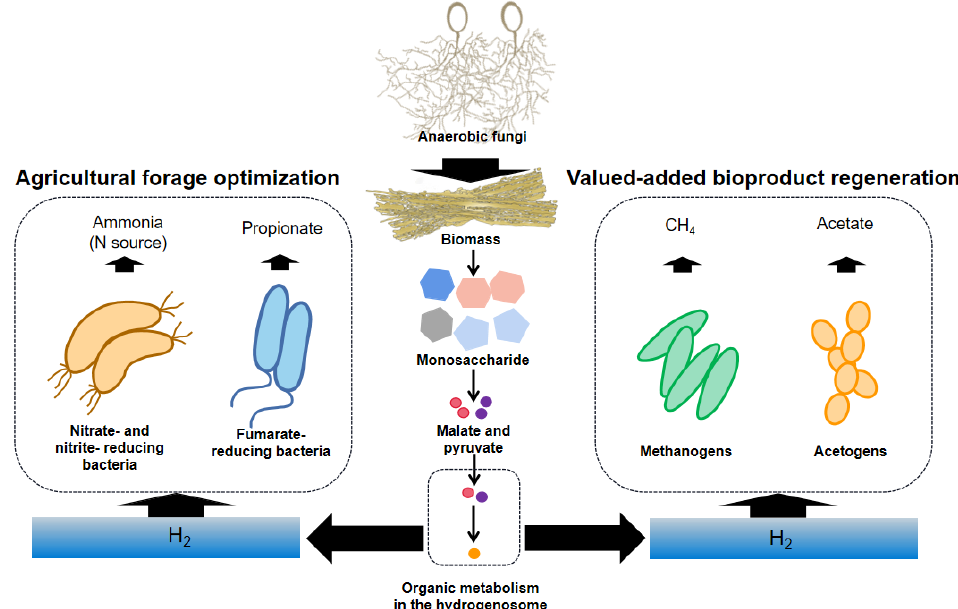
Figure 6. The role of the hydrogenosome and its metabolites. The metabolites (mainly H 2 ) can be used by nitrate- and nitrite-utilizing bacteria, fumarate-reducing bacteria, methanogens, and acetogens to produce other substances that can be used.